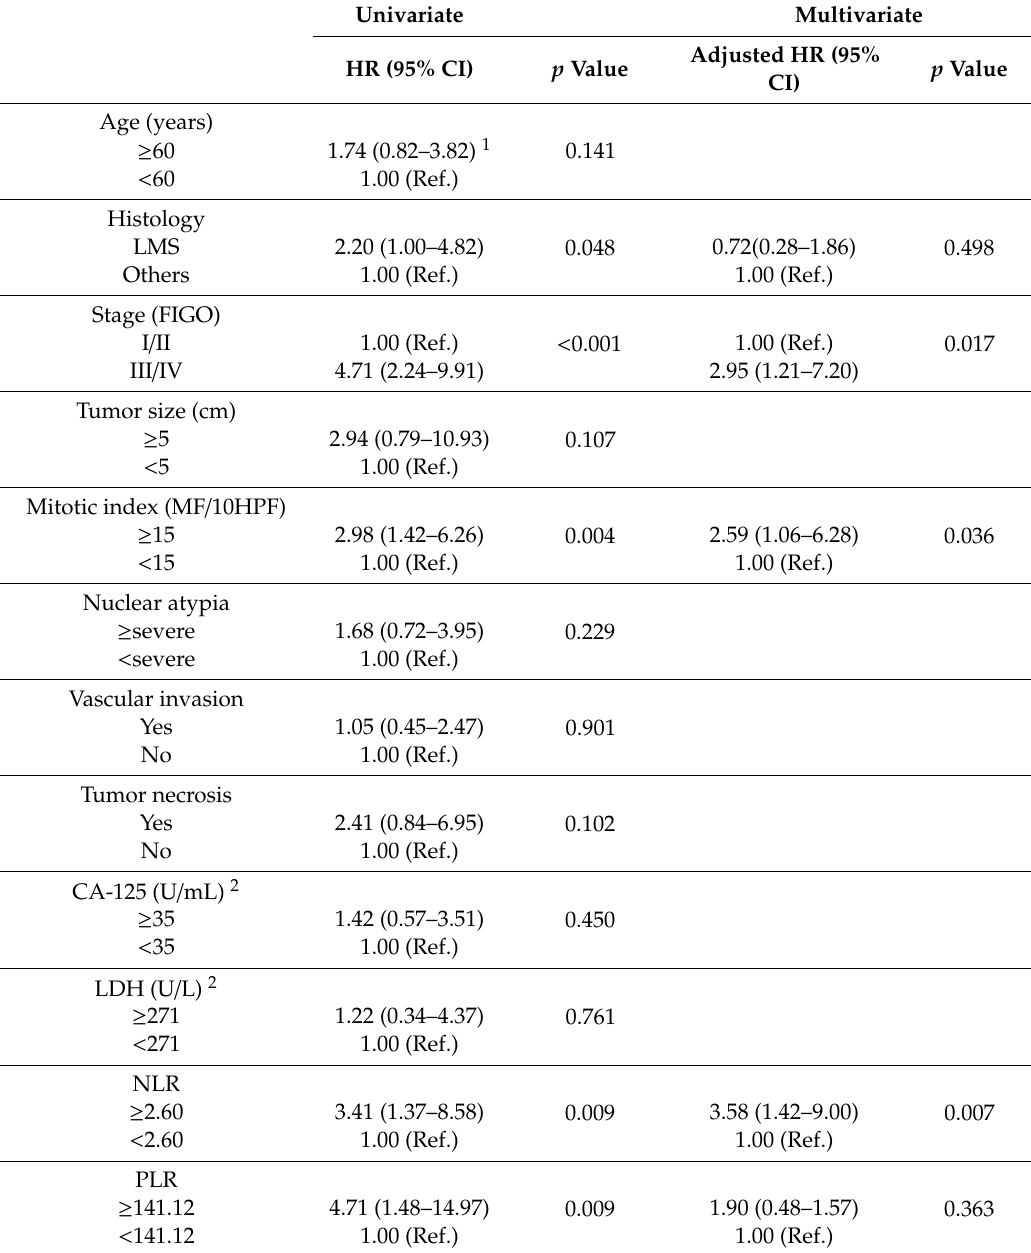
Table 2. Univariate and multivariate analysis of prognostic factors for disease-free survival ( n =